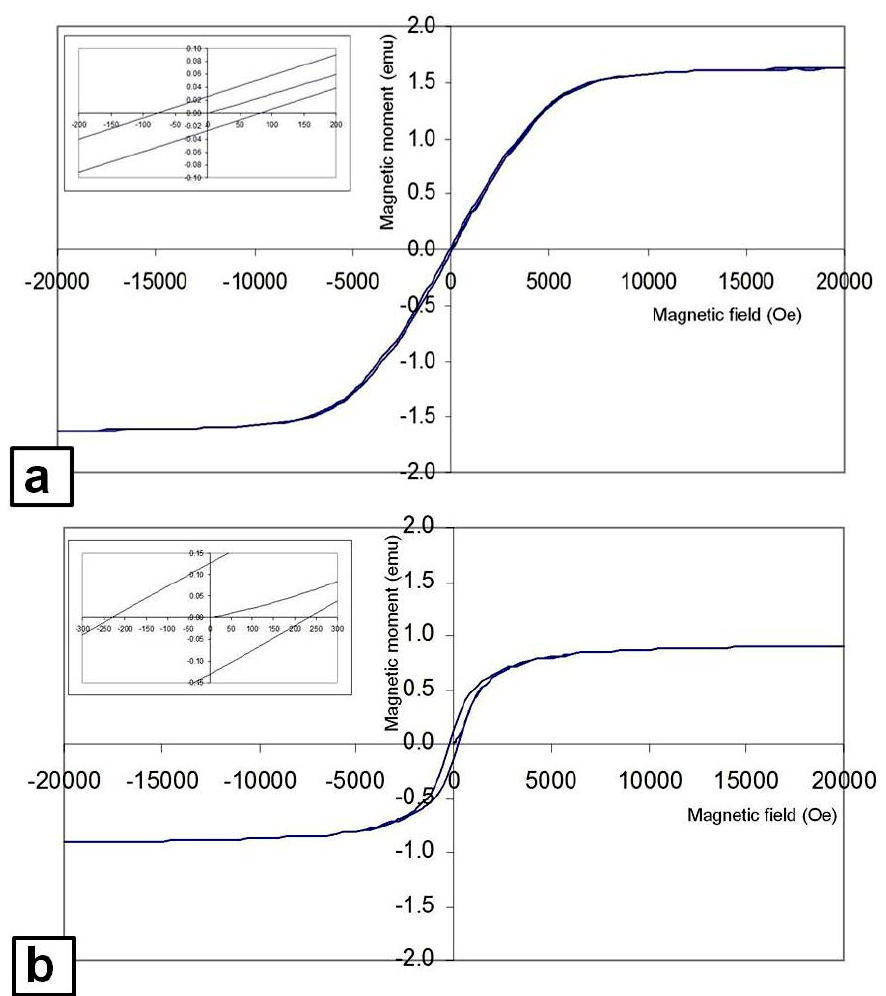
Figure 12. Magnetization hysteresis loops for nugget zone contained dispersed: ( a ) Fe; and ( b ) Fe 3 O 4 particles through FSP.